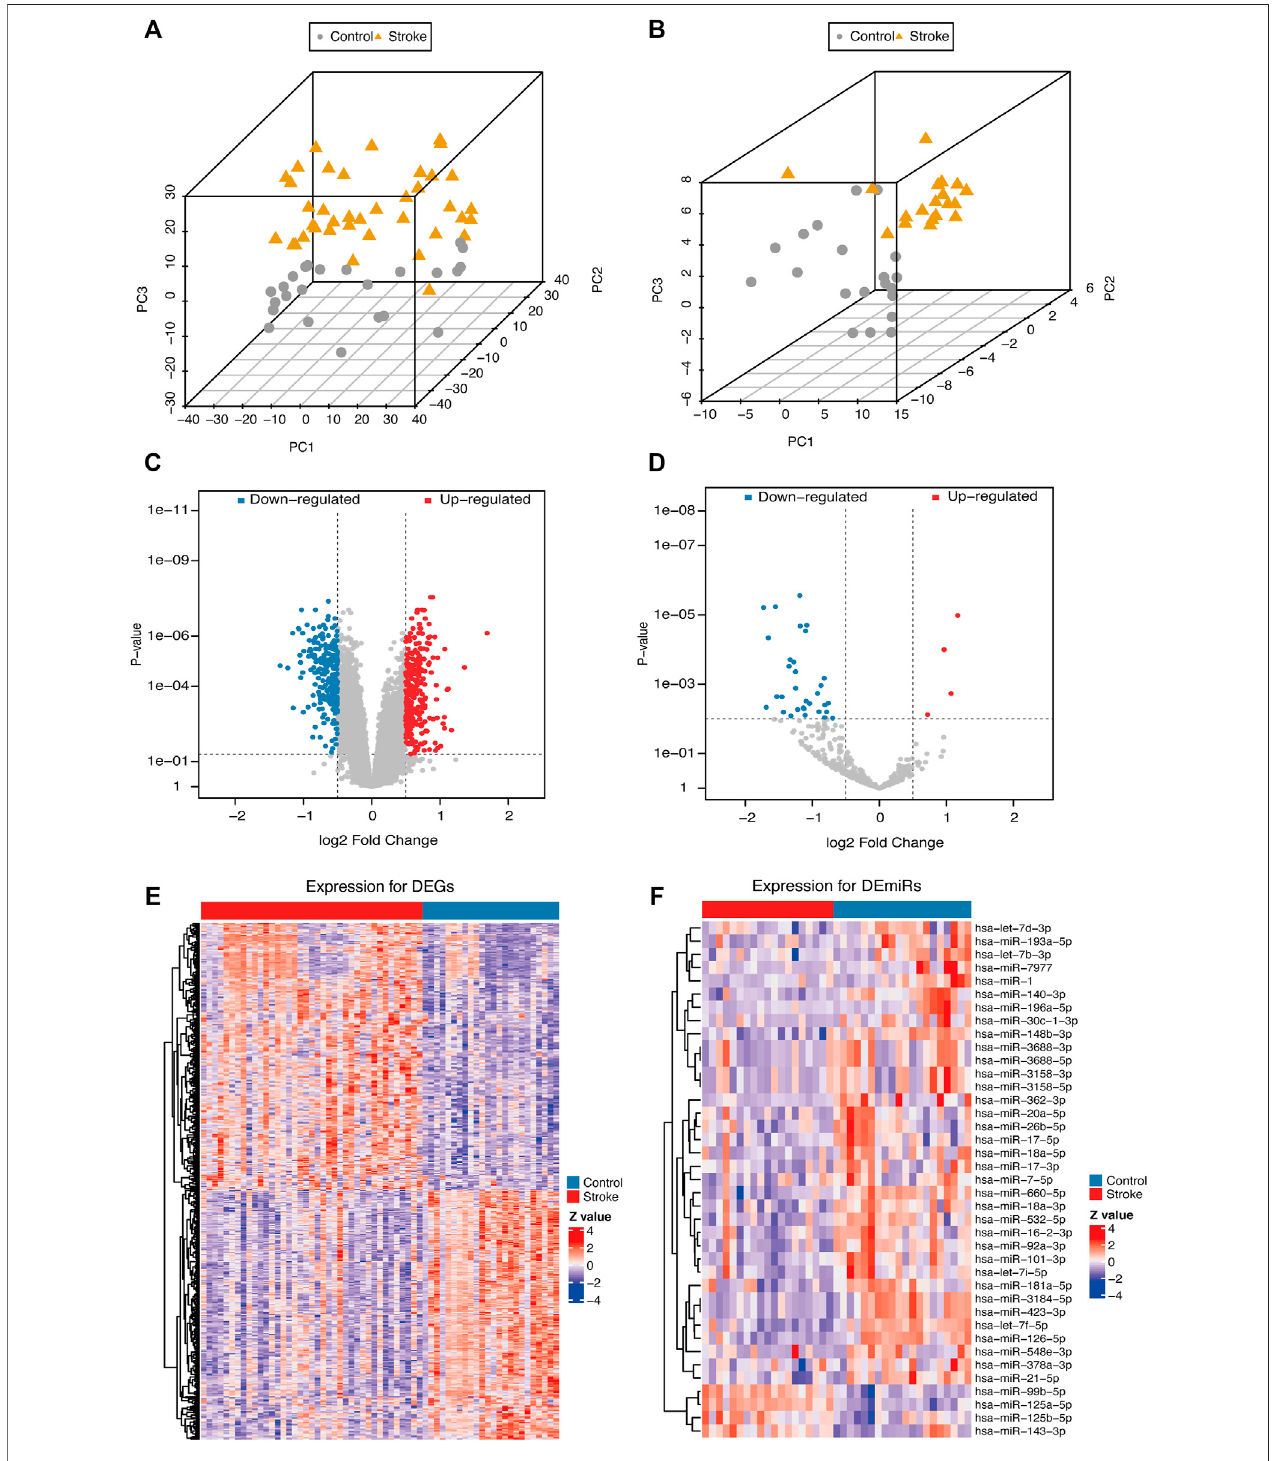
FIGURE 3 | PCA plots and differential expression of the samples of the data sets after correction. PCA plots of the GSE16561 (A) and GSE110993 (B) datasets afterremovingtheinter-batchdifferences.VolcanoplotsoftheGSE16561 (C) andGSE110993 (D) dataset;redplotrepresentedupregulation,andblueplotrepresented downregulation. Heat maps of the GSE16561 (E) and GSE110993 (F) datasets. The color scale represented the abundance of gene expression. The darker the color shade, the higher expression level.